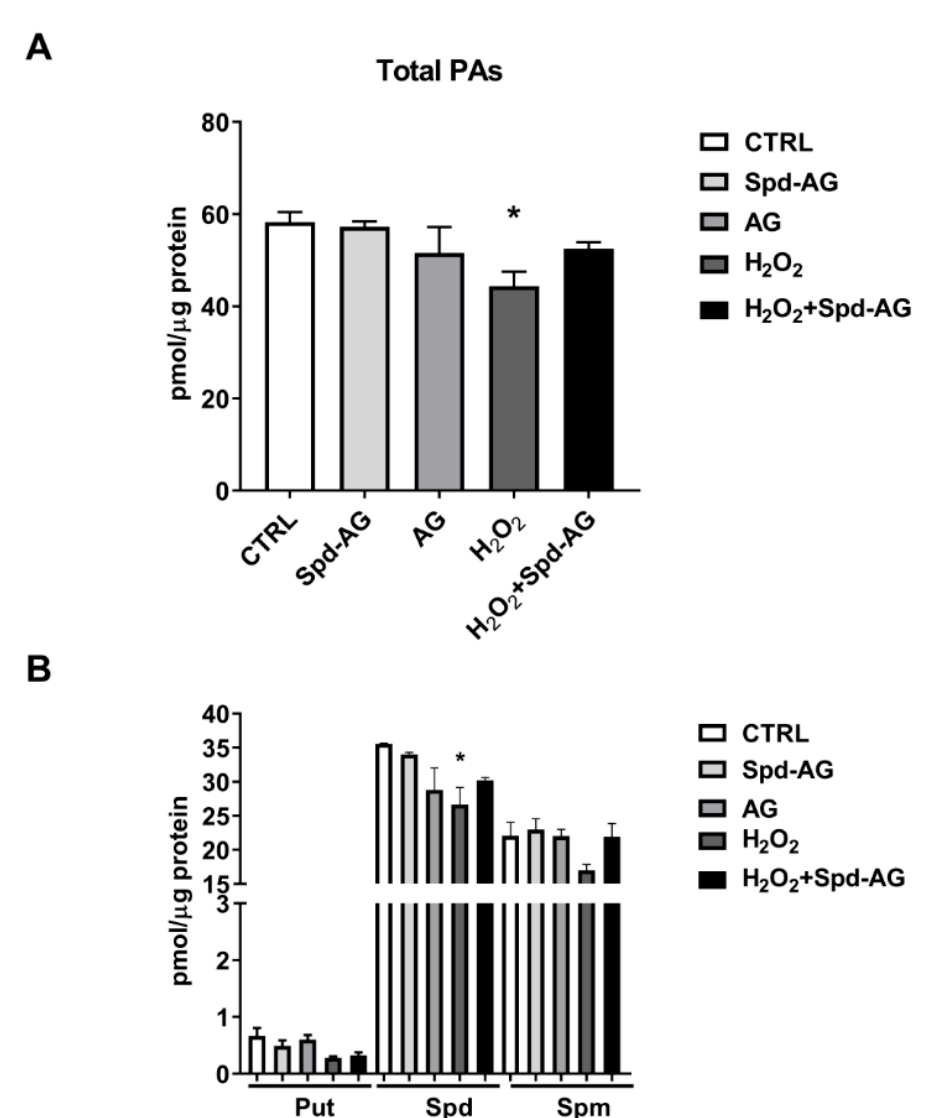
Figure 9. Effect of Spd-AG and H 2 O 2 on C2C12 myoblast polyamine content. Cells were treated with Spd 10 µ M, AG 1 mM, H 2 O 2 0.3 mM and combined treatments for 6 h. ( A ) Total polyamine content; ( B ) Put, Spd and Spm levels. Data presented are the mean ± SEM of three experiments, each performed in triplicate. One-way ANOVA was performed with Bonferroni’s multiple comparison test * p < 0.05.